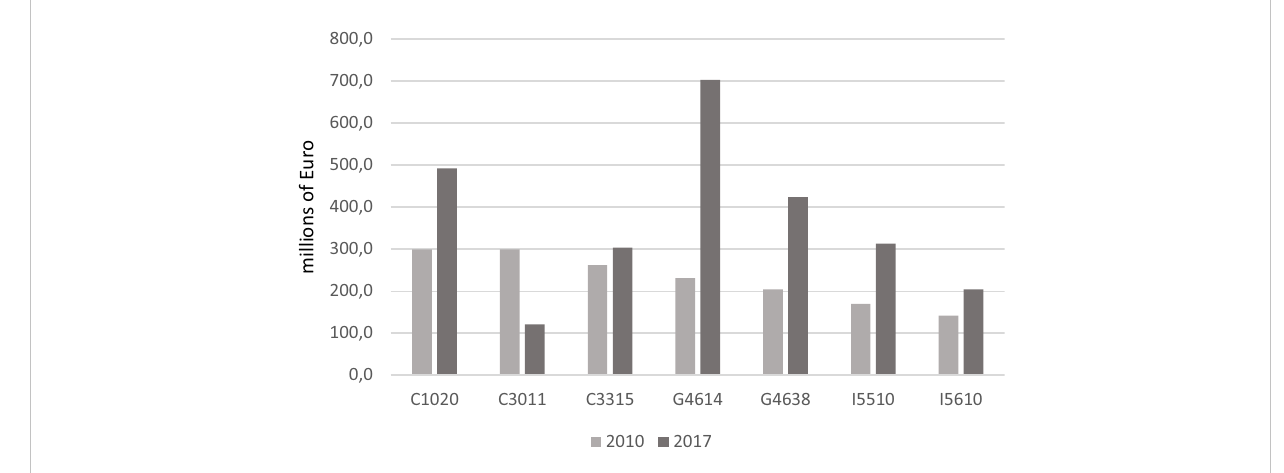
FIGURE 5 The largest subclasses of the Polish blue economy in 2010 compared with 2017. Source: own